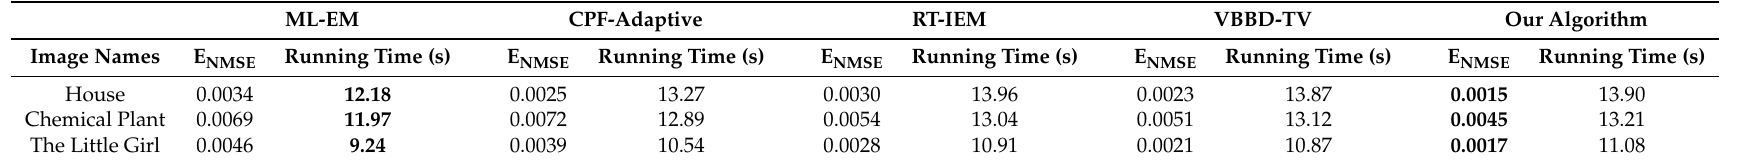
Table 2. Comparison results on E NMSE and running time of different restoration